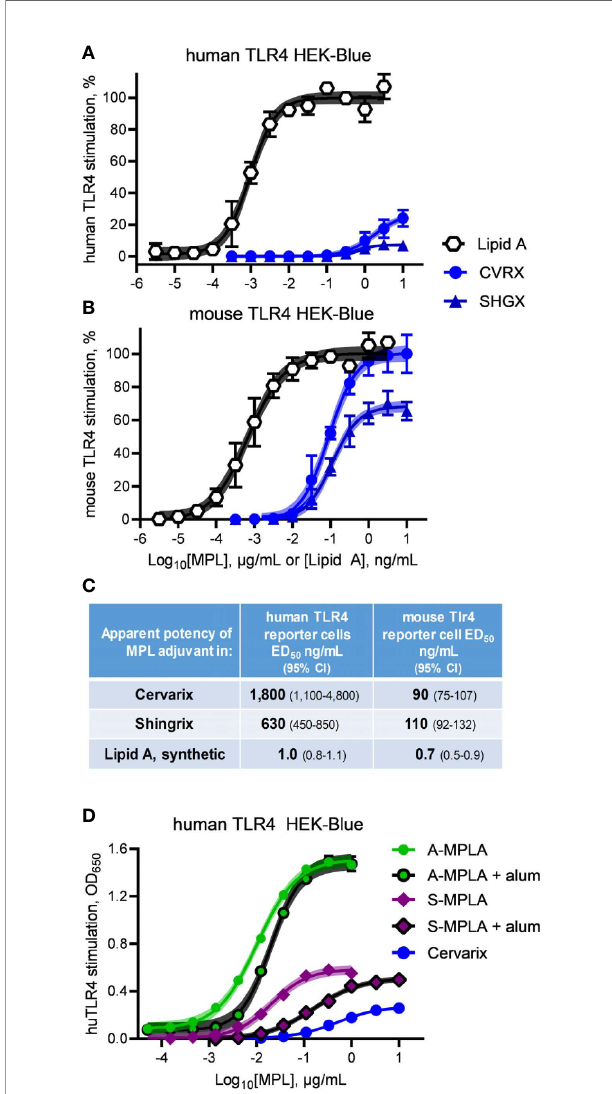
DC FIGURE 3 | Clinical-grade MPL adjuvant is a partial agonist of human TLR4. Clinical-grade MPL adjuvant ® was evaluated for human vs mouse TLR4 dose response pro fi les by exposing (A) human TLR4 and (B) mTLR4 HEK-Blue reporter cells to Cervarix vaccine (CVRX) or the AS01 adjuvant component of Shingrix vaccine (SHGX) for 24 h. 100% = the top dose plateau for Lipid A- induced secretion of alkaline phosphatase, which was used to normalize TLR4 stimulatory activity between the two reporter cell-lines for a combined total of three independent experiments. (C) MPL adjuvant ® was 5 – 16% as potent an agonist of human TLR4 than it was of mouse TLR4 as determined by stimulatory curve fi tting to calculate ED50 for the curves shown in (A, B) . Low dose plateaus of human TLR4 responses to MPL adjuvant ® relative to Lipid A and mouse TLR4 responses, indicate it is a partial agonist of human TLR4. (D) human TLR4 HEK-Blue cells were treated with MPLA adsorbed on alum and compared to MPLA alone; alum adsorption did not decrease ef fi cacy of two MPLA preparations. Curve fi tting to calculate the top dose plateaus with and without alum produced the following values (with 95% con fi dence intervals): A-MPLA, 1.51 (1.49 – 1.53) vs A-MPLA + alum, 1.49 (1.47 – 1.52); S-MPLA, 0.59 (0.57 – 0.60) vs S-MPLA + alum, 0.51 (0.50 – 0.53). Shaded regions indicate 99% con fi dence intervals within which the true population means should occur 99% of the